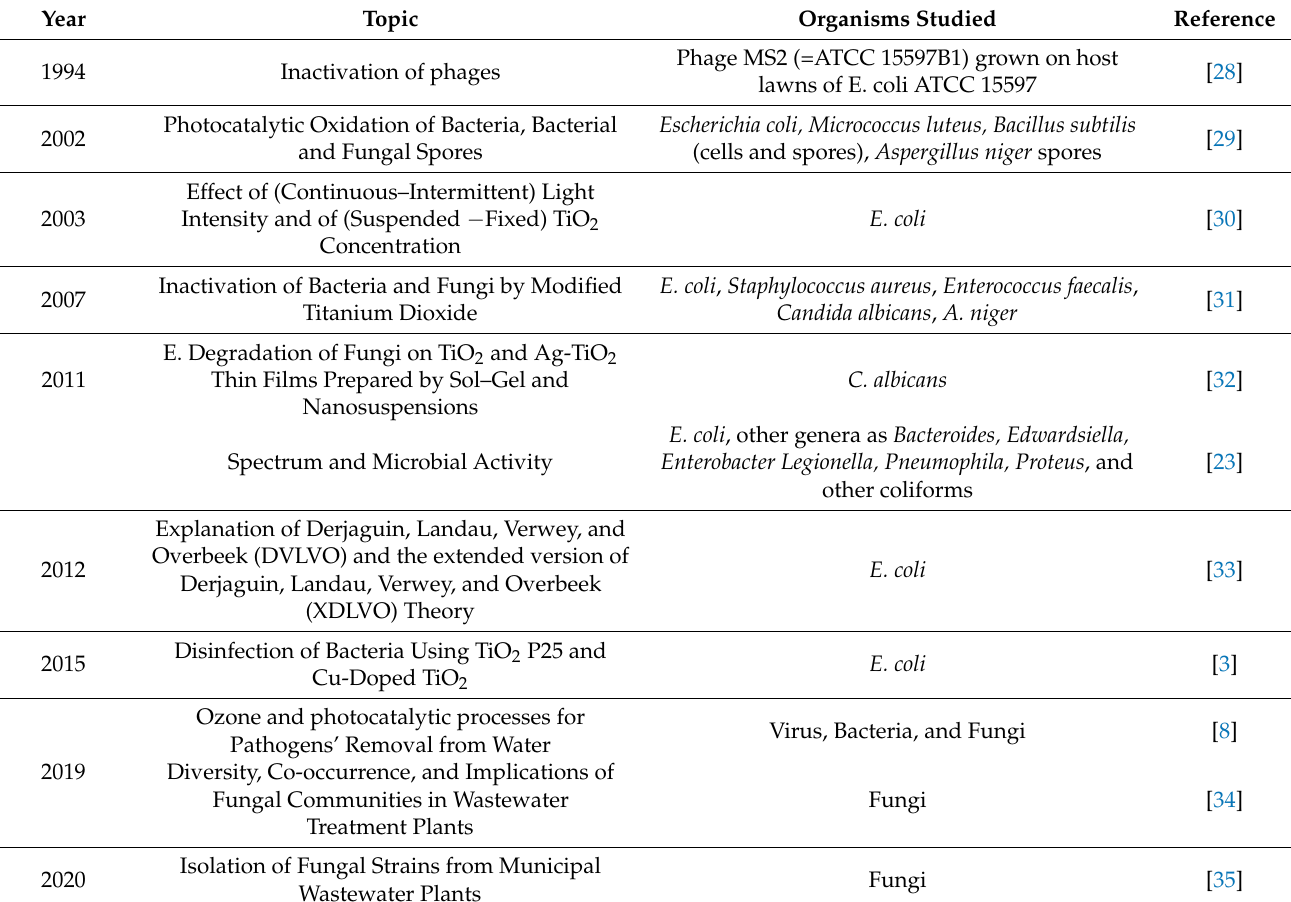
Table 1. Some works on disinfection of organisms using TiO 2